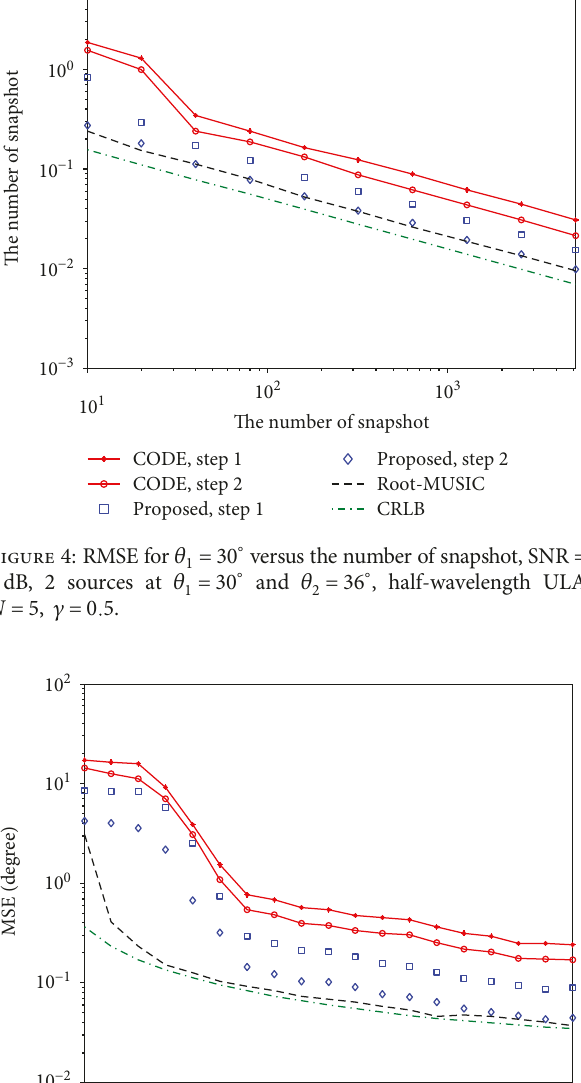
= 30 ° versus angle separation, T = 100 , 1 = 30 ° and θ = 30 ° + Δ θ , half-wavelength 1 2